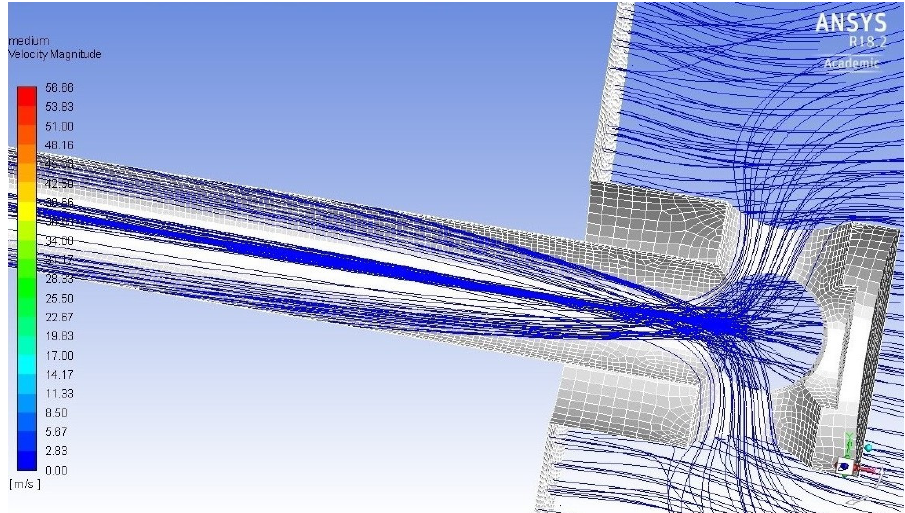
Figure 2. Particles trajectories inside the Elegant Breadboard’s inlet head and duct .